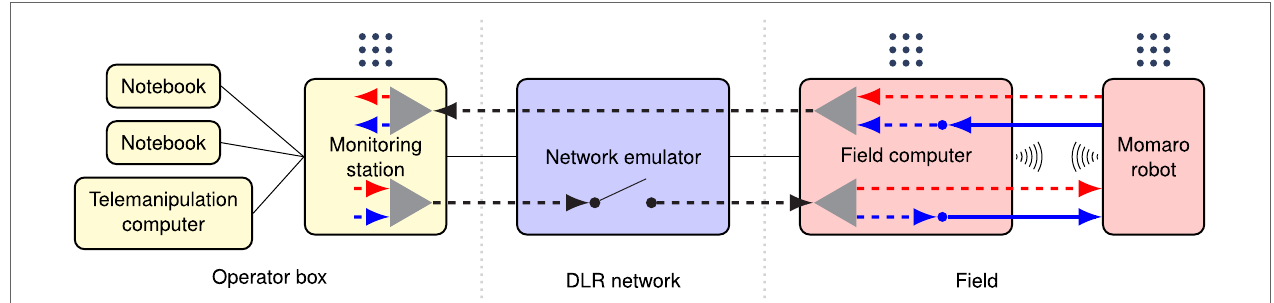
FIGURE 10 | Communication architecture . Components in the vicinity of the operators are shown in yellow, DLR-provided components in blue, and components in the “arena”-network in red. Solid black lines represent physical network connections. Thick lines show the different channels, which stream data over the network (dotted: UDP, solid: TCP). The ROS logo ( ) indicates a ROS master. UDP tunnel endpoints are designated by triangles. Streaming links (Section 9.1.2) are colored red, message links (Section 9.1.3) are shown in